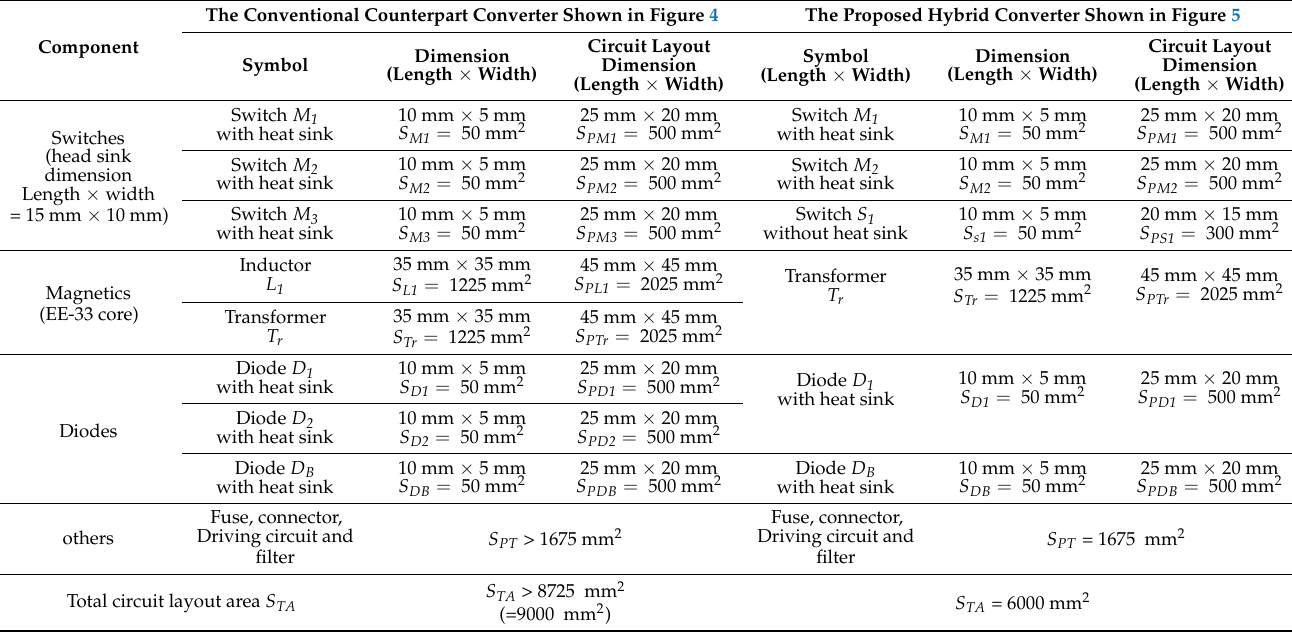
Figure 16. Photo of the proposed hybrid converter prototype. Table 6. Layout area comparison between the propose hybrid converter and the conventional counterpart